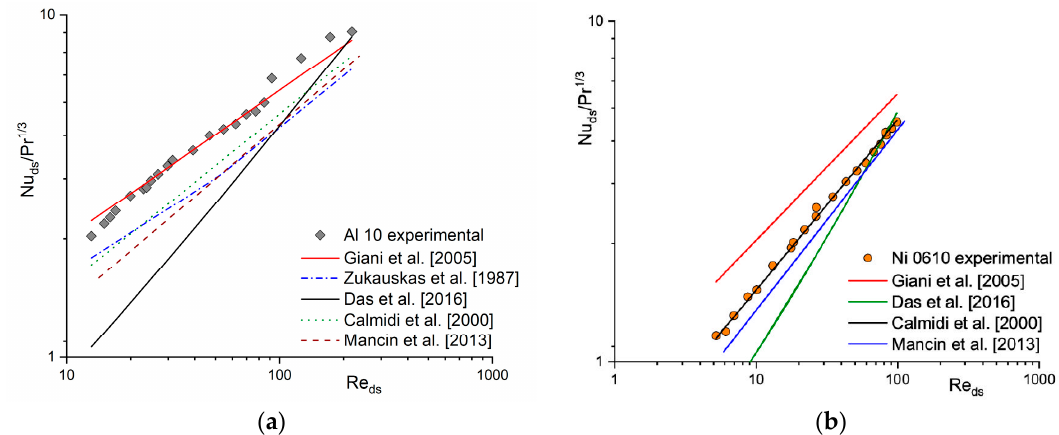
Figure 2. Experimental heat transfer results and those calculated based on the literature correlations for ( a ) Al 10 and ( b ) Ni 0610 foams.